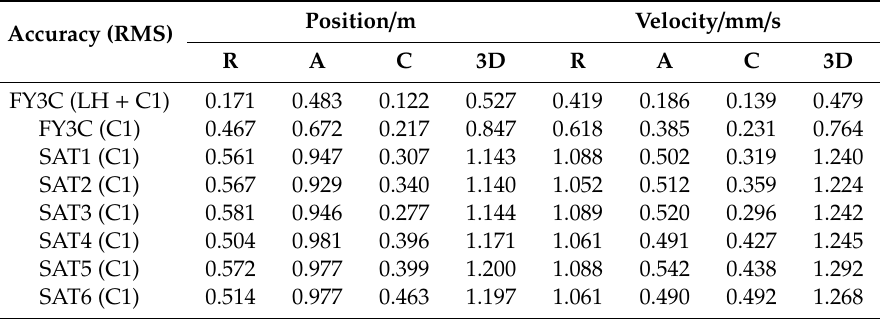
Figure 8. Daily real-time orbit accuracy of the YG30/SAT1 − SAT6 satellites for the pseudo-range-based solution: ( a ) The radial (R), along-track (A), cross (C) and 3-dimensional (3D) position accuracy; ( b ) The R/A/C/3D velocity accuracy. Table 3. The overall statistics of real-time orbit accuracy.